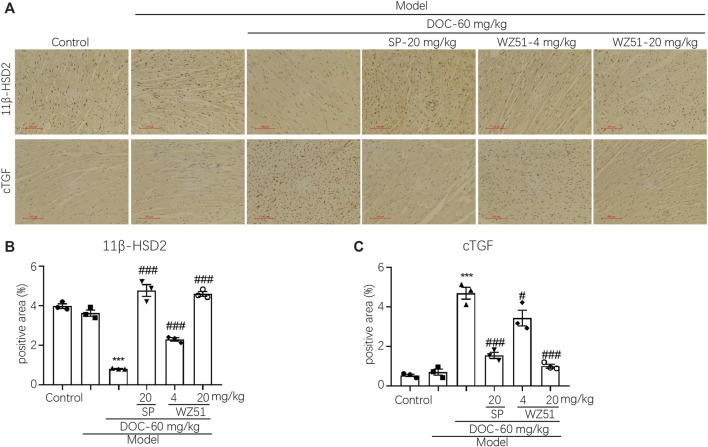
CTGF expression was upregulated, whereas 11β-HSD was inhibited in the heart tissues of renal hypertensive rats. (A, B) CTGF and 11β-HSD were determined by histochemistry. Representative images were shown (200 × magnification). (C, D) Statistical analysis of histochemistry (CTGF and 11β-HSD) (***p < 0.001 vs. CON; #
p < 0.05, ###
p < 0.001 vs. DOC; n = 3).